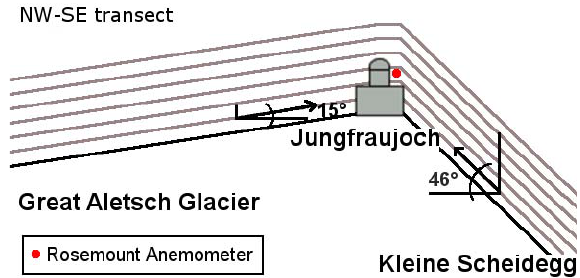
Fig. 5. Influence of the topography on the vertical wind field around the Jungfraujoch. Air masses are assumed to follow the terrain, i.e. the flow lines are assumed to be parallel to the surface in the lowest layers. The mean inclination angles at the mean cloud base posi- tions are ≈ 15 ◦ and ≈ 46 ◦ at the southeastern and northwestern side,